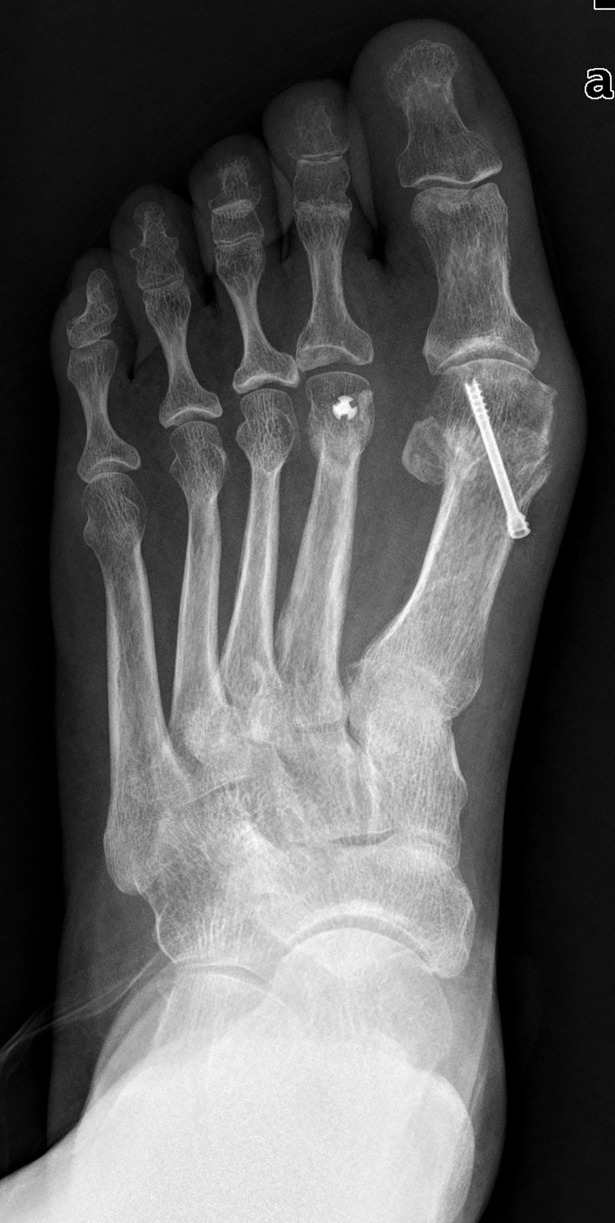
4 months after operation.The excessive length of the first ray had not been addressed.